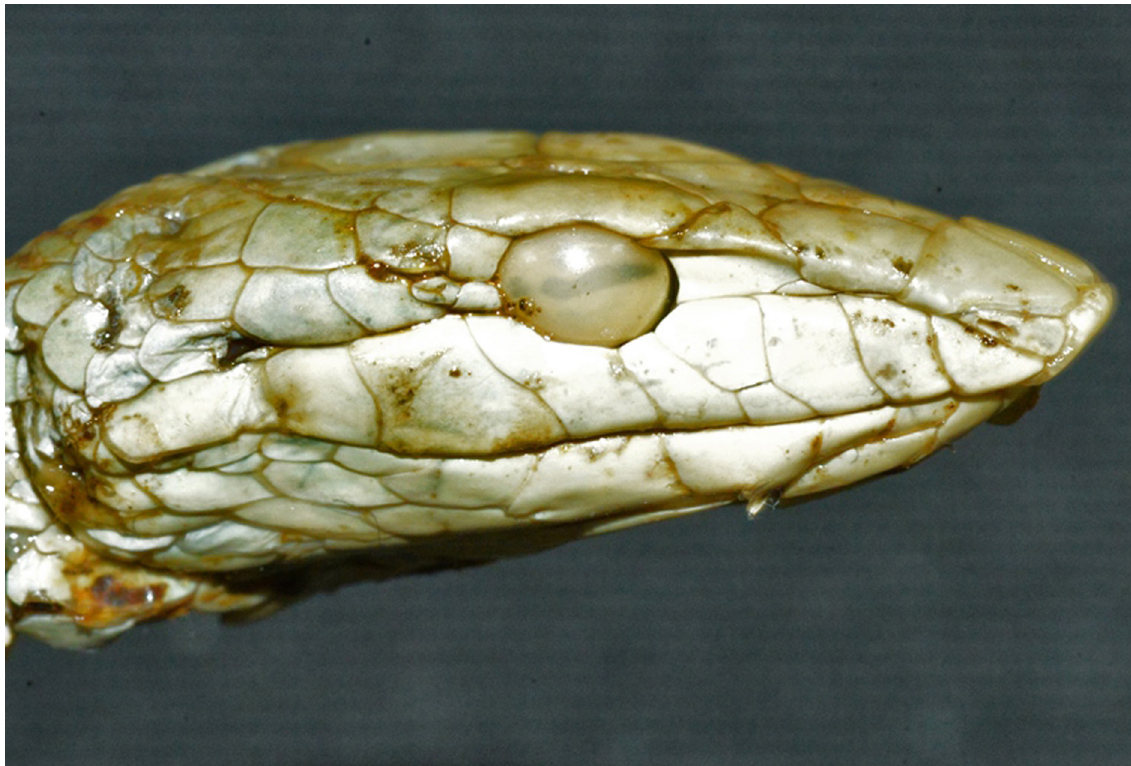
Fig. 5. Dryophis prasinus var . flavescens Wall, 1910, lectotype (NHMUK 1908.6.23.58). Head close-up showing the divided 4 th supralabial on right side, a unique identifying character in ascertaining its type status. Photo: © The Trustees of the Natural History Museum,